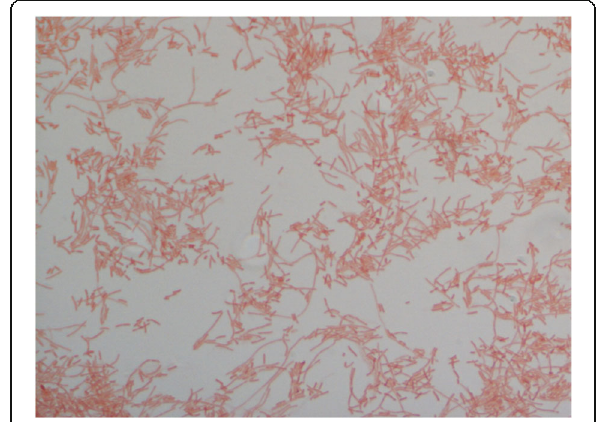
Fig. 3 Gram staining of Fermentimonas caenicola strain